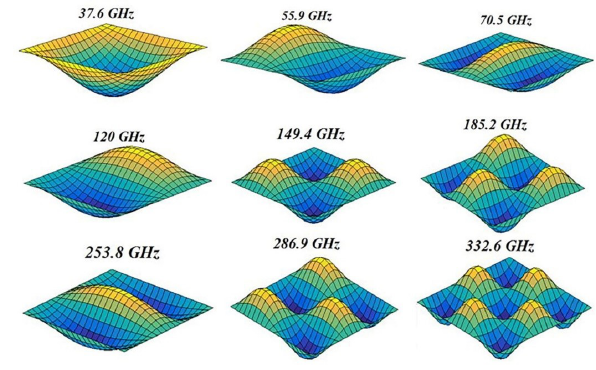
Figure 7: Various vibrational mode shapes of the